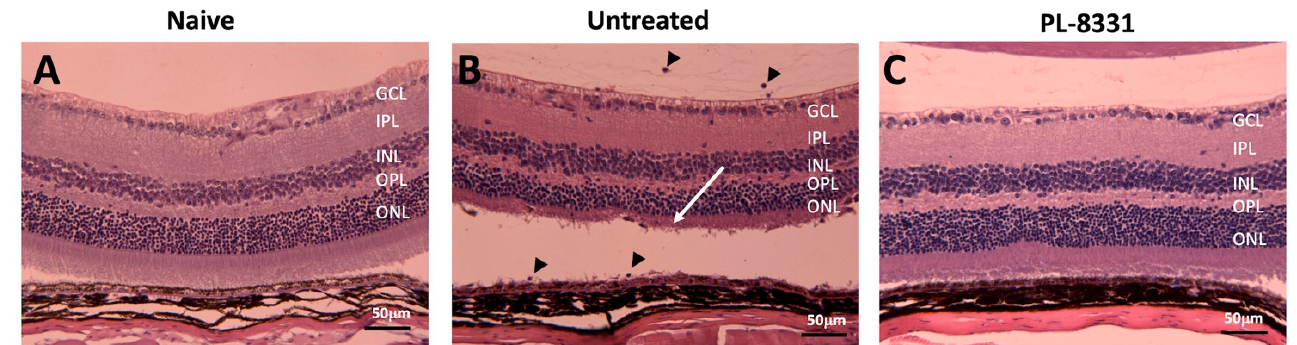
Figure 2. The effects of PL-8331 treatment on retinal histology in EAU mice. Photomicrographs of the histology of retinas from treated mice 10 weeks after immunization with IRBP and treatment. ( A ) The retinal structure of naive mice demonstrated normal thickness and lengthy photoreceptors. ( B ) The retinas of the EAU mice treated with PBS (vehicle) had noticeably shortened photoreceptor lengths with disruptions of the ONL (arrow). Also, there were infiltrating inflammatory cells (arrowheads). ( C ) The retinal structure in EAU mice treated with PL-8331 has a similar appearance as the retinas of naive mice. The separation of the retina from the RPE was an artifact of the fixation. Four sections of the eyes from the 4 mice in Figure 1 were examined. The scale bar is 50 µ m in length. GCL—Ganglion Cells Layer, IPL—Inner Plexiform Layer, INL—Inner Nuclear Layer, OPL—Outer Plexiform Layer, ONL—Outer Nuclear Layer, Phr—Photoreceptors.